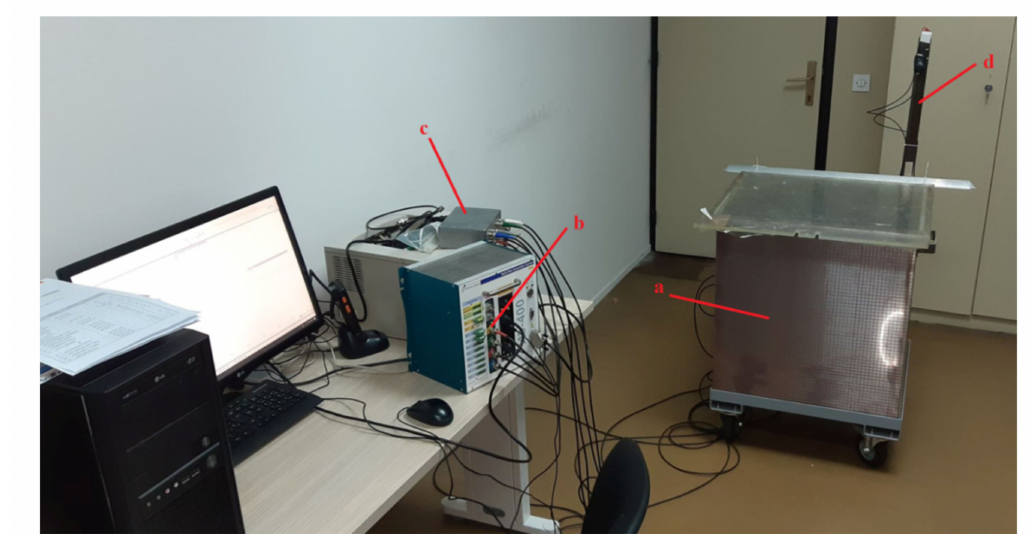
Figure 10. Photograph of the experimental setup: ( a ) stainless steel tank filled with transformer oil; ( b ) Picoscope 5444D oscilloscope card; ( c ) conditioning circuitry; and ( d ) PD spark source attached to the end of the metal meter immersed in the transformer